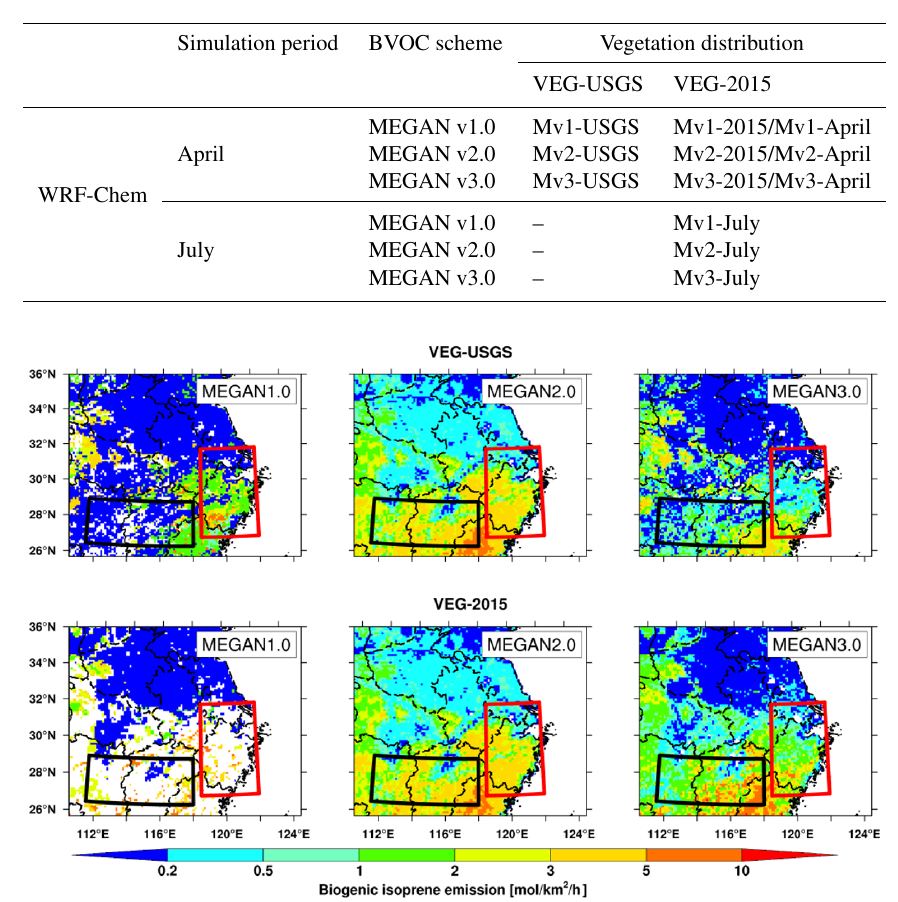
Figure 3. Spatial distributions of biogenic isoprene emissions averaged in April over the simulation domain estimated with different biogenic emission schemes and vegetation datasets as listed in Table 2. Two areas are marked by red and black boxes to discuss the characteristics in